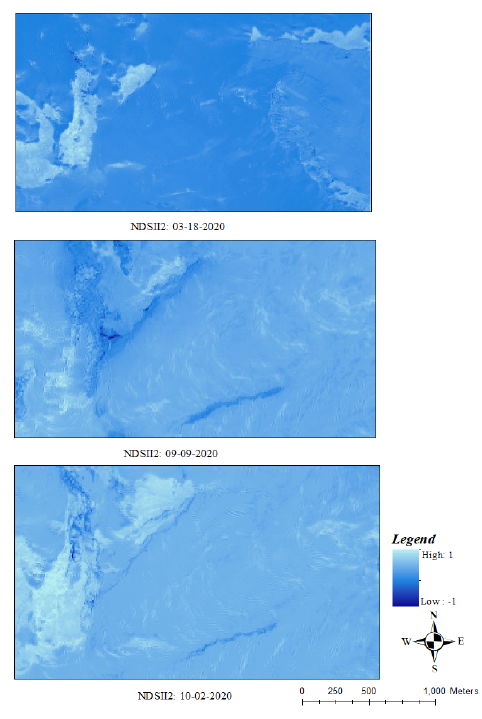
Figure 4: Area of interest for visual inspection